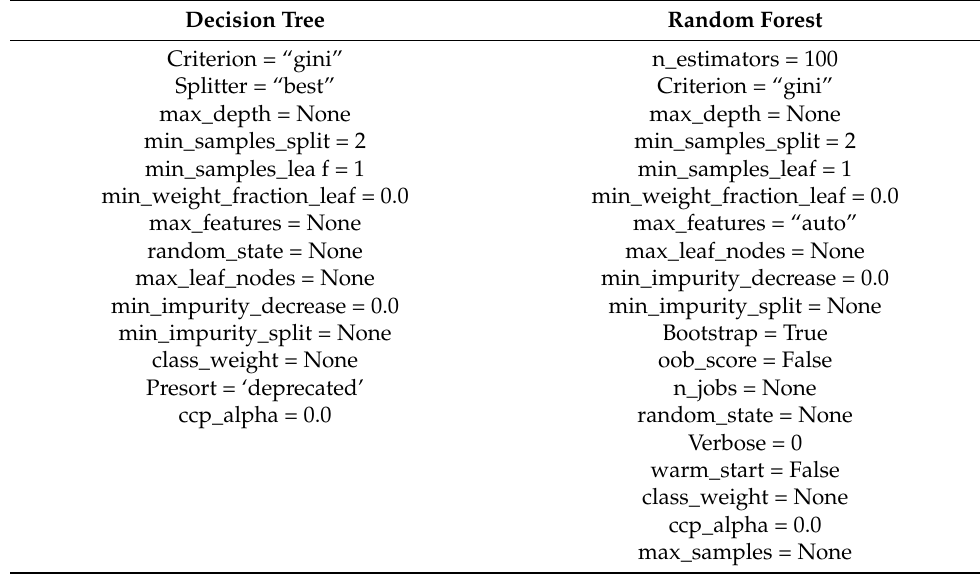
Table 6. The default parameters of decision tree and random forest